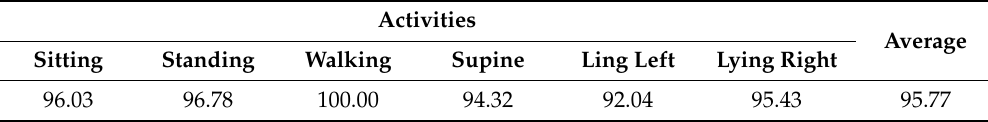
Table 7. The ADL classification results on DS2 using Naïve Bayes (NB) with the top ten features derived from DS1.